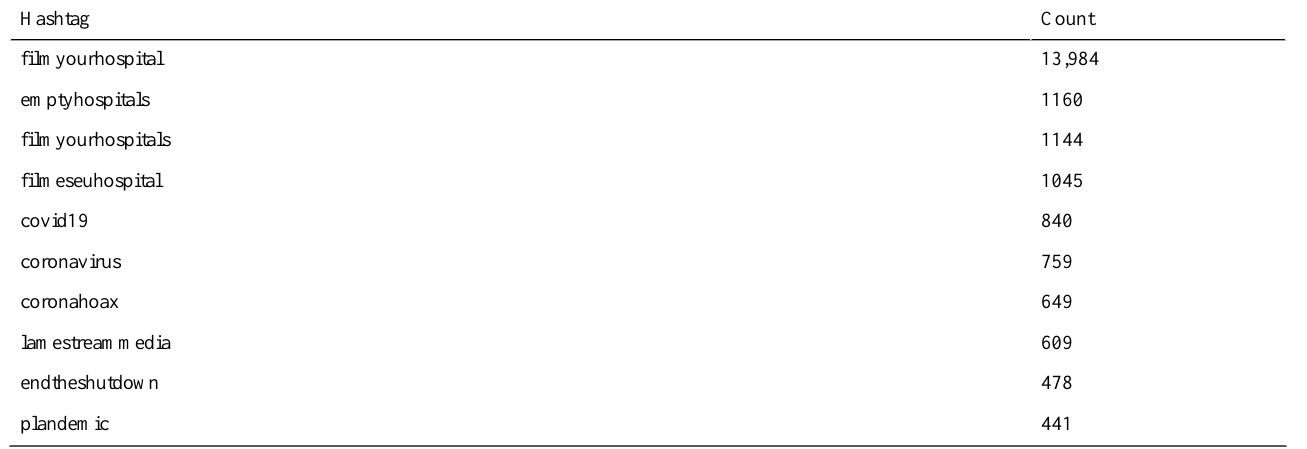
Table 3. Most shared hashtags.